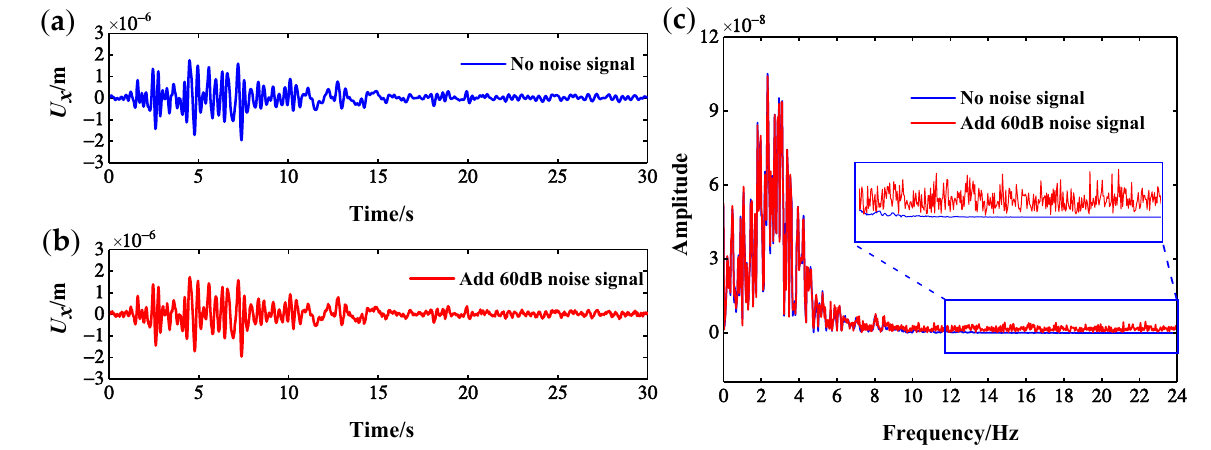
Figure 18. Time–frequency diagram before and after adding 60 dB noise: ( a ) no noise signal; ( b ) additional 60 dB noise signal; ( c ) frequency spectrum.